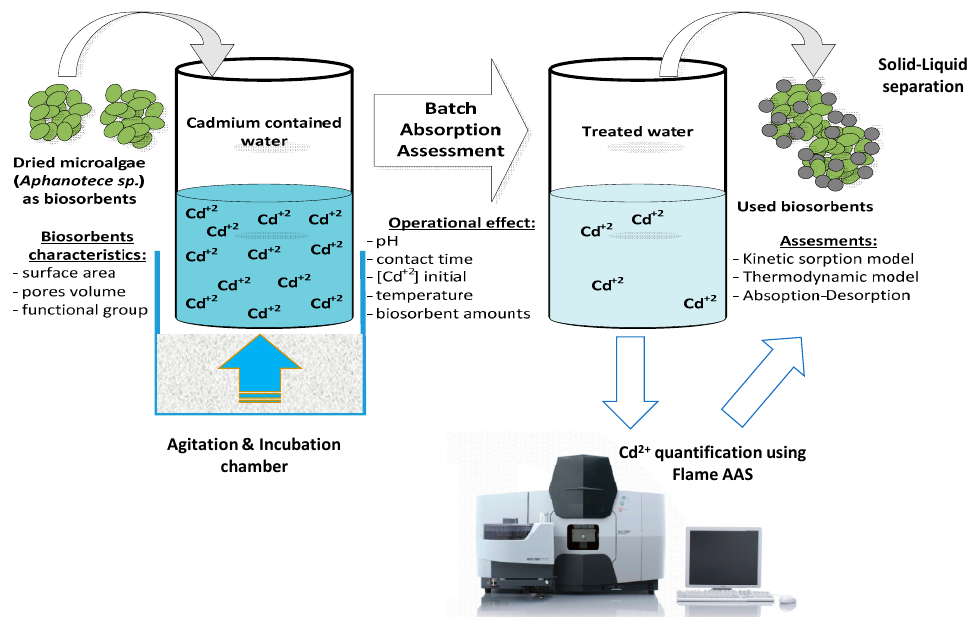
Figure 1. The schematic batch mode experiment to assess the e ffi ciency of biosorbent ( Aphanothece sp .) for Cd 2 + ion